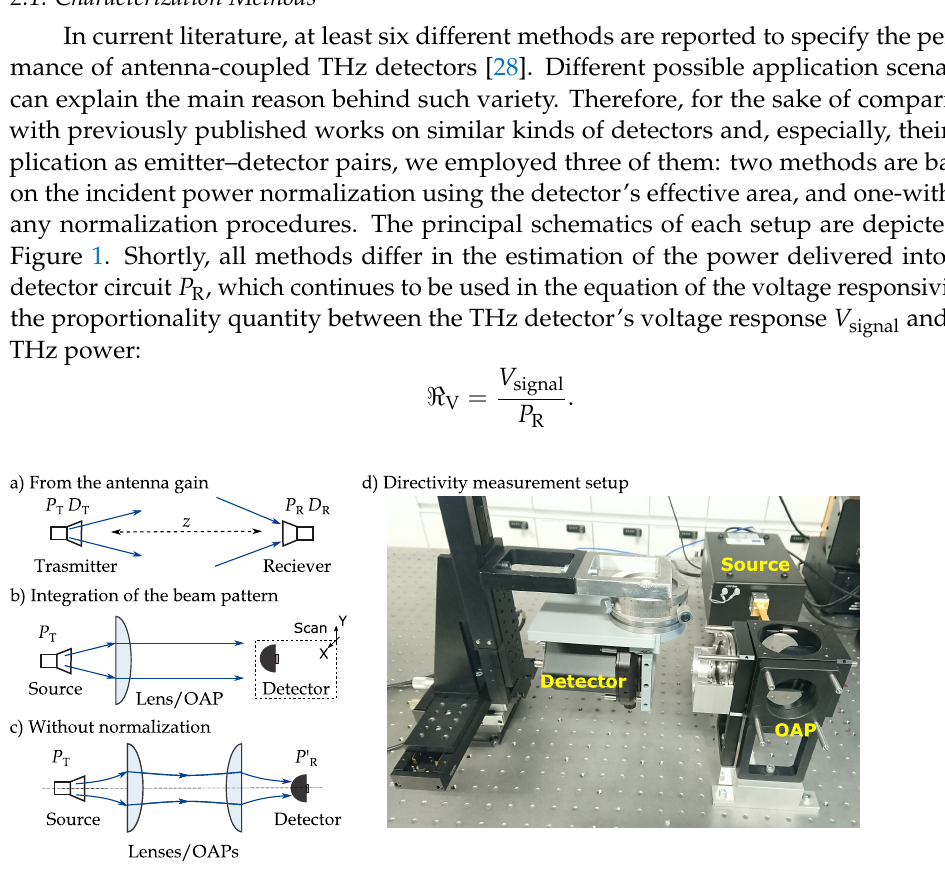
Figure 1. ( a – c ) The methods for the detector performance parameters characterization. ( d ) The detector directivity measurement setup. OAP, off-axis parabolic